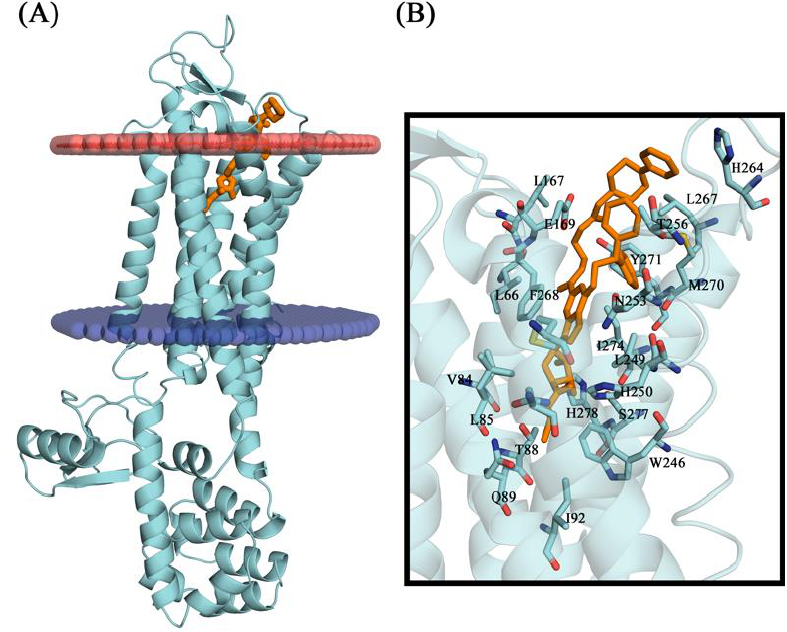
Figure 14. ( A ) Schematic representation of the type 2 adenosine receptor. In red the extracellular side is represented and blue represents the cytoplasmic side. ( B ) Binding site of the protein with the compound UK-432097. Table 12. Compounds selected, BindingDB codes and their respective biological activity values. Compound Code